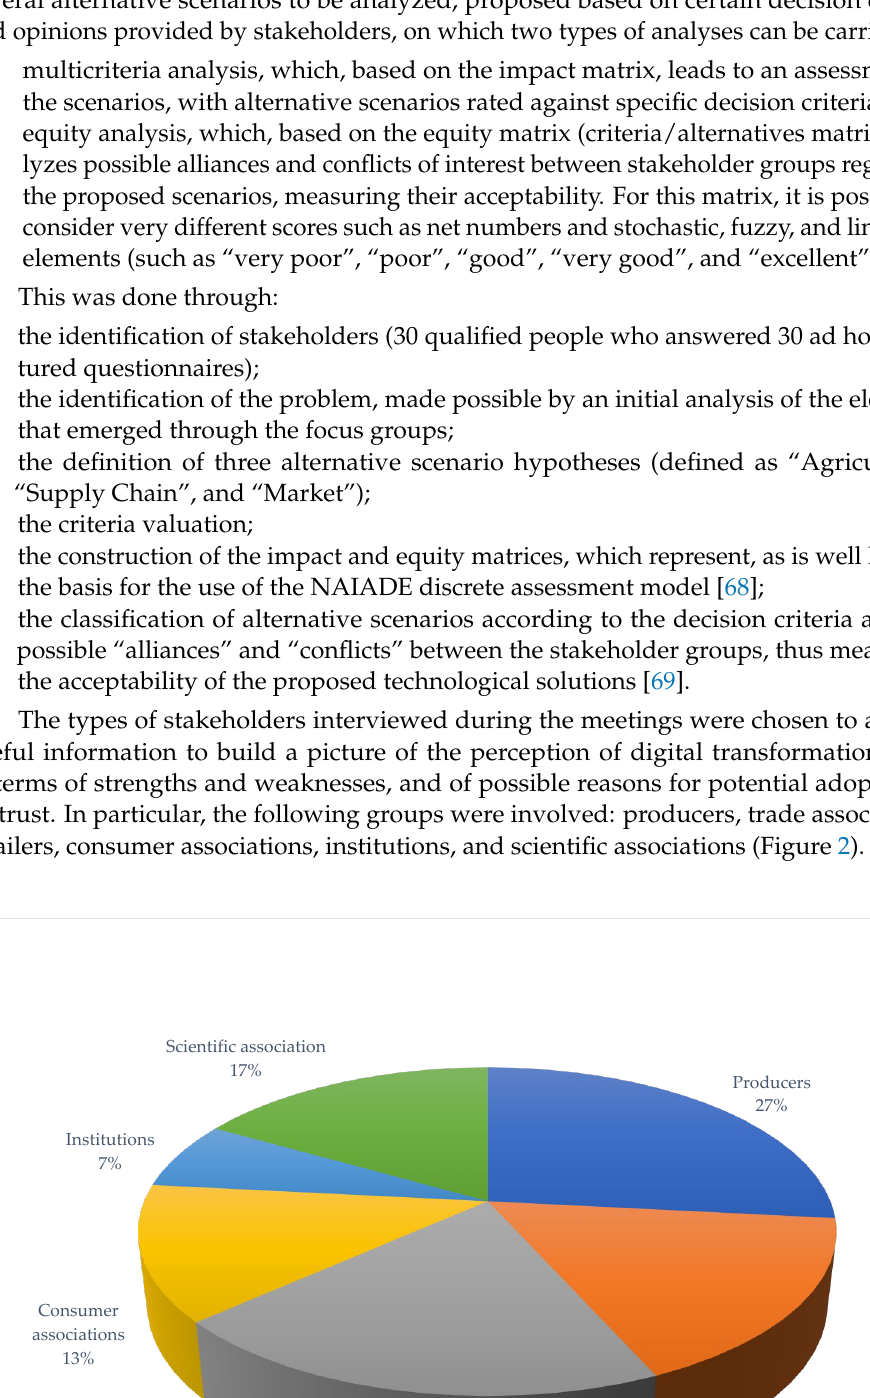
Figure 1. The proposed methodological approach.